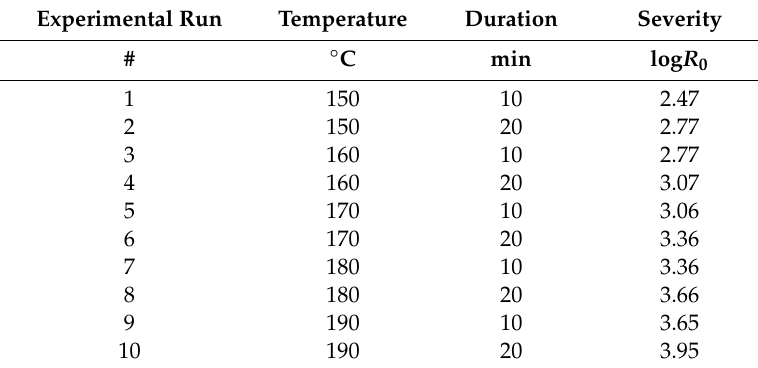
Table 1. Experimental plan with reaction